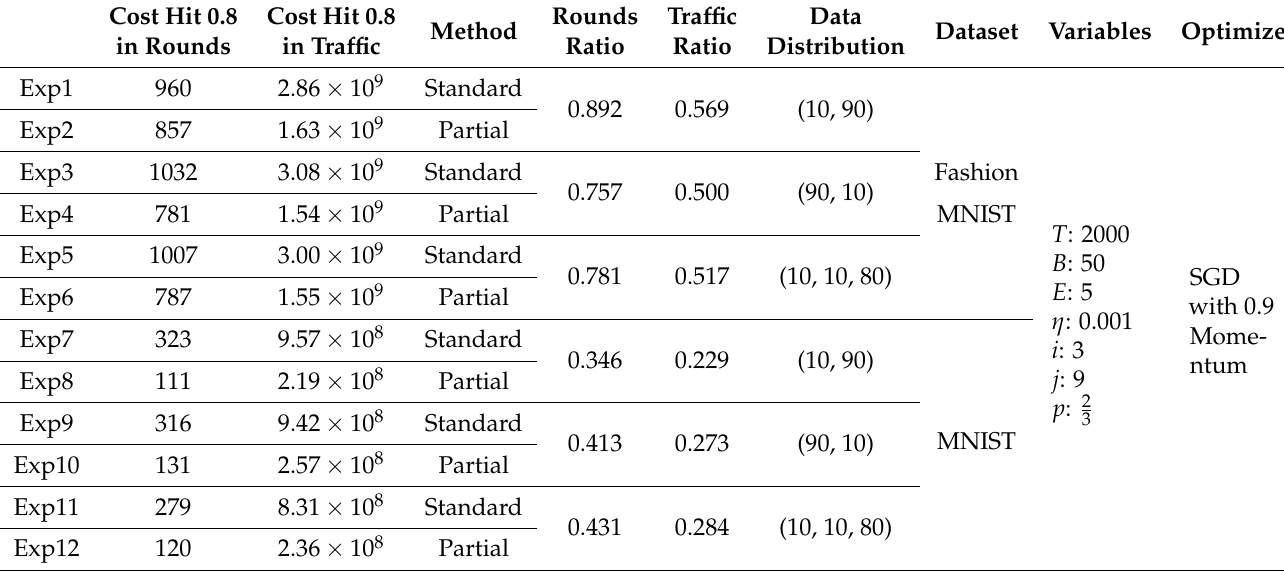
Table 1. This table shows the federated learning results of the image classification model using the standard method and the proposed algorithm, FederatedPartial. The ratios represent the cost of FederatedPartial compared to the standard method. Cost Hit 0.8